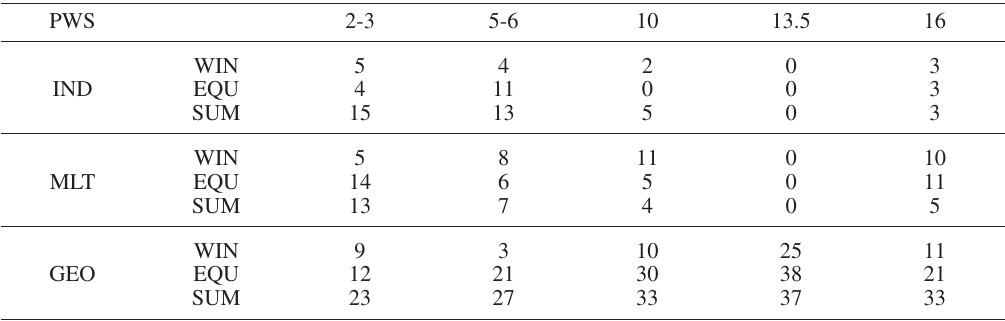
Table 10.I. Percentages of seasonal occurrence of the different PWS in the f 0 F 2 according to their possible drivers. WIN means from November to February, EQU means March, April, September and October, and SUM means from May to August. MLT means PWS driven by PW activity in the MLT, GEO by the geomagnetic ac- tivity and IND means PWS events ‘independent’ from the above two (after Altadill and Apostolov,